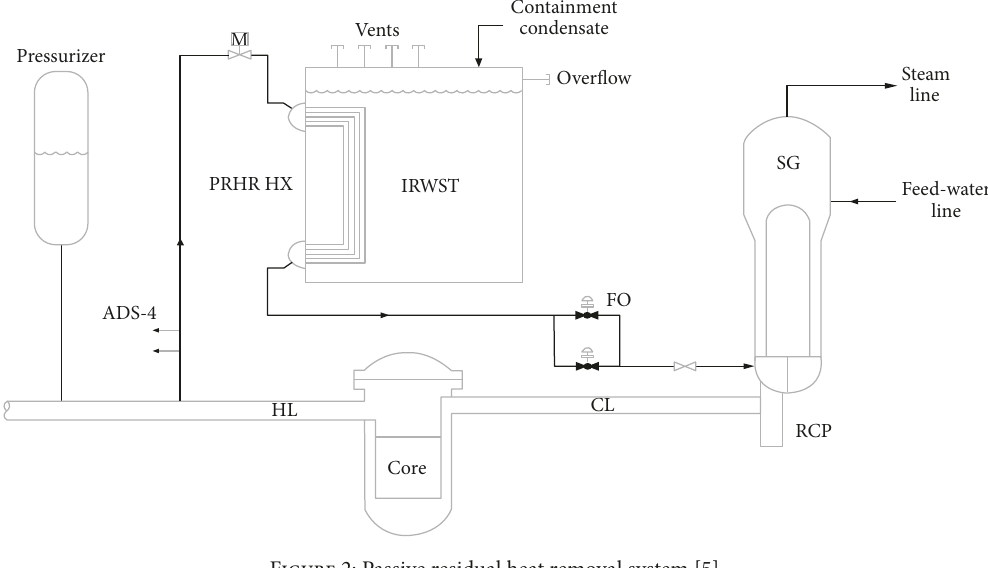
Figure 2: Passive residual heat removal system [5].